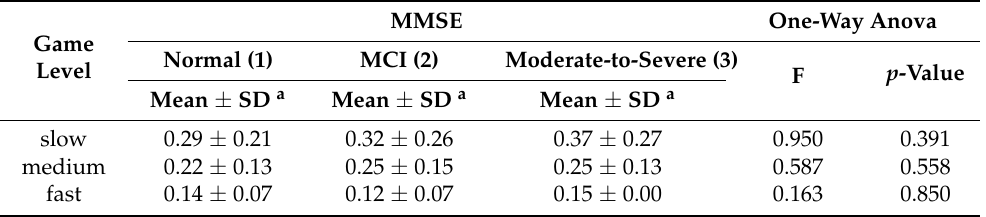
Table 10. Response times of subjects at different game level(s)